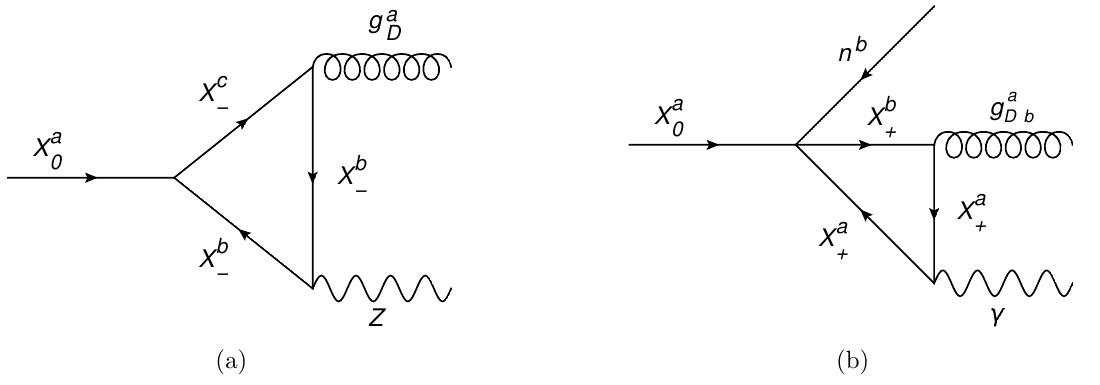
Figure 10. (a) Example decay of a neutral X S color index is in the adjoint representation for the (cid:12)rst case and in the fundamental for the second.